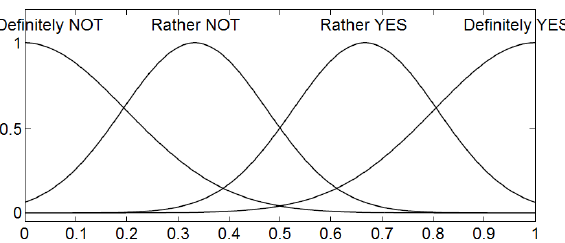
Figure 12: Membership function for the output variable y – IRF(Uph) , Gaussian functions